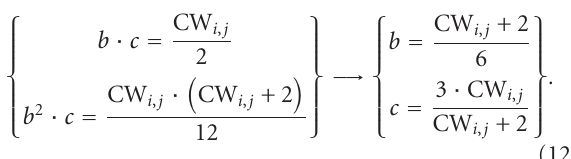
equations result in corresponding c and b . Hence,